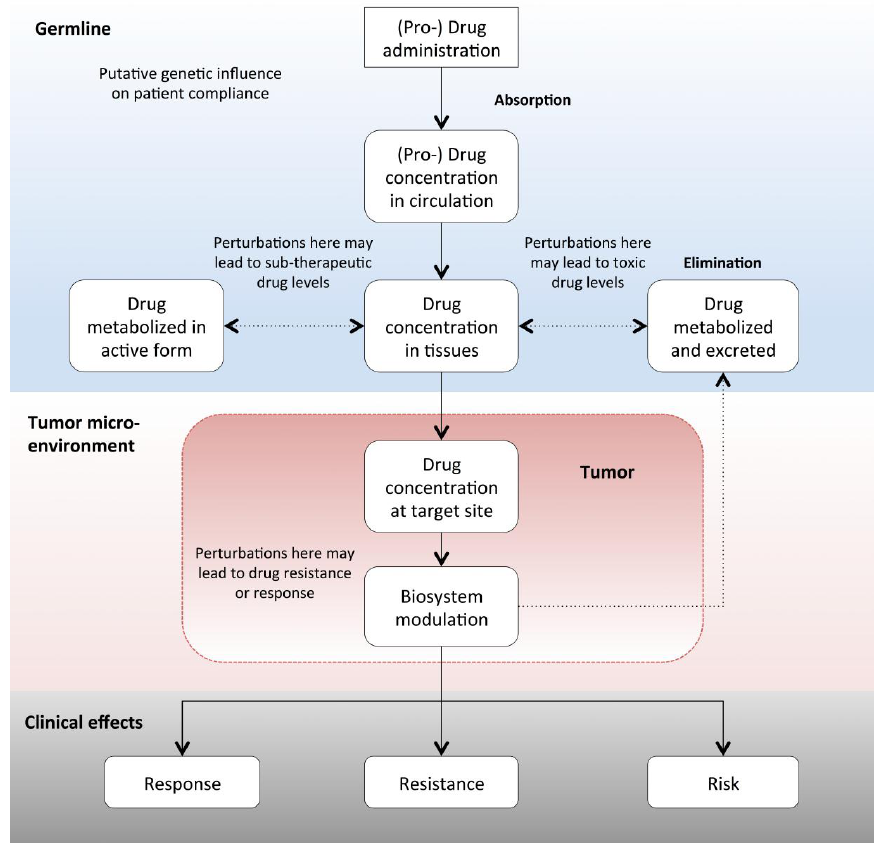
Figure 1. Schematic overview of the molecular path followed by orally administered anti-cancer drugs and the biological contexts in which genomic variation can a ff ect treatment response, resistance and / or risk / safety. Factors a ff ecting drug resistance can occur at any level, even potentially starting with patient compliance. Non-somatic mutations can a ff ect drug pharmacokinetics leading to critical variations in available concentrations of active drug species, often associated with sub-therapeutic (i.e., drug resistance) or supra-therapeutic (i.e., drug toxicity) levels of drug concentration. Tumor specific genomic variation not only influences the pharmacodynamics of drug treatment at an intrinsic level, but variants such as tumor mutational burden can also extrinsically influence the interaction between the tumor and its microenvironment. It is primarily the sum of all these potential e ff ects that defines clinical outcomes in response to treatment with anti-cancer